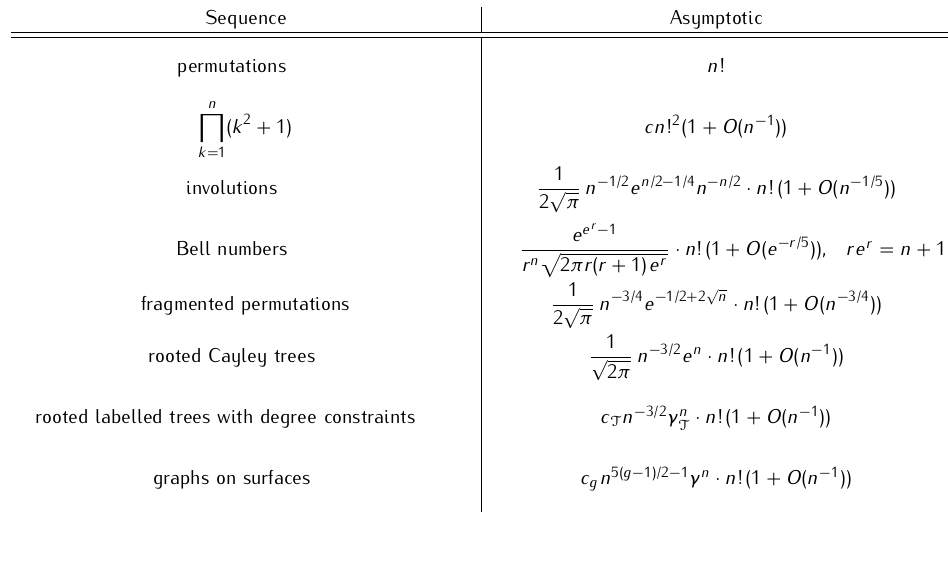
Table 1. Combinatorial families and their enumerative asymptotic